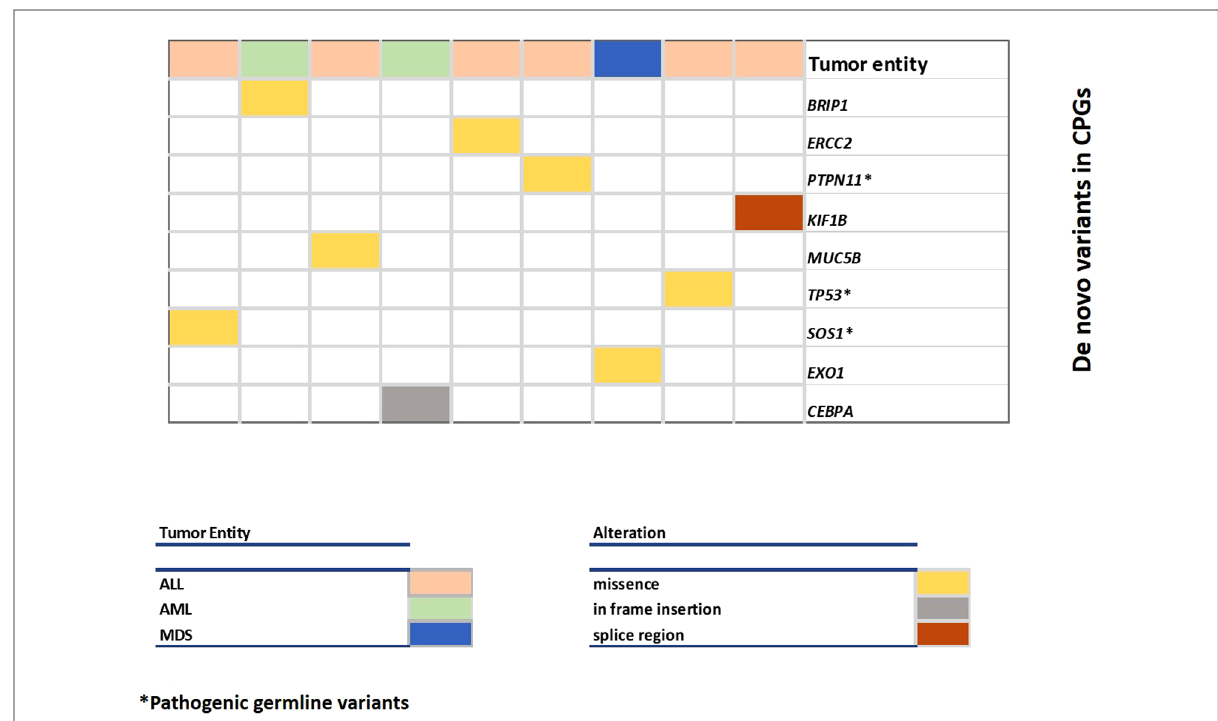
FIGURE 2 Overview of DNVs in cancer predisposition genes. Each column represents a case and each row represents a gene. The color of the columns indicates the type of malignancy (leukemia, myelodysplastic syndrome) and the color of the row indicates the type of